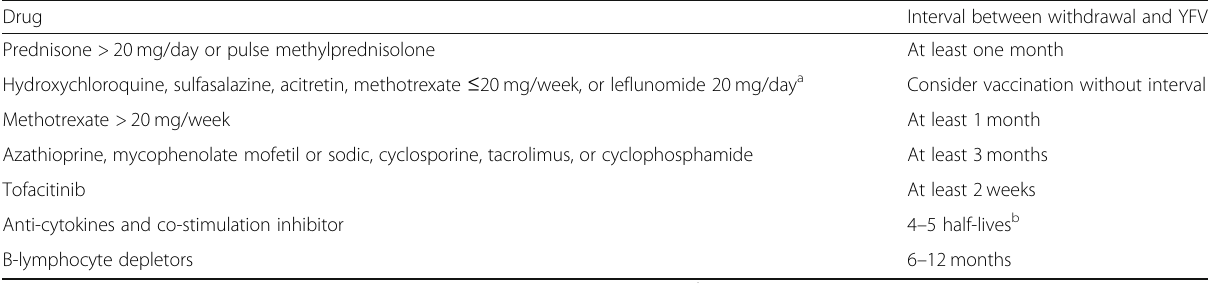
Table 4 Minimal period recommended between therapy withdrawal and yellow fever vaccination in patients with CIMID Drug Interval between withdrawal and YFV Prednisone > 20 mg/day or pulse methylprednisolone At least one